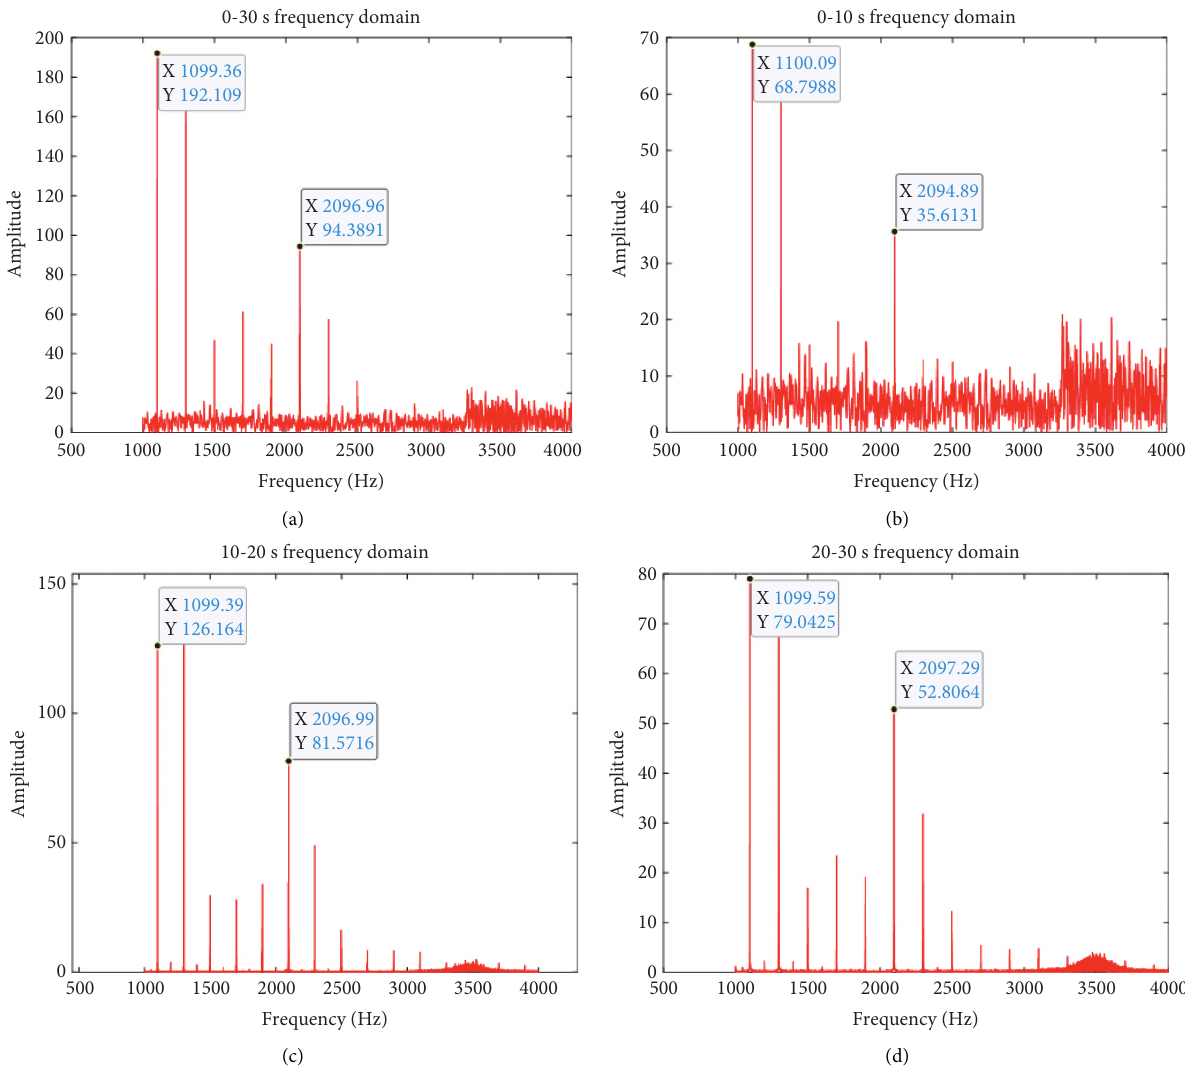
Figure 19: Oscillation characteristics of the prestage. (a) 0 ∼ 30s frequency domain. (b) 0 ∼ 10s frequency domain. (c) 10 ∼ 20 s frequency domain. (d) 20 ∼ 30 s frequency domain.